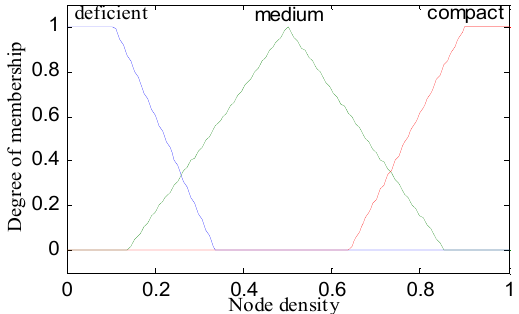
Figure 2. Membership function of NDBS (node distance to the base station).